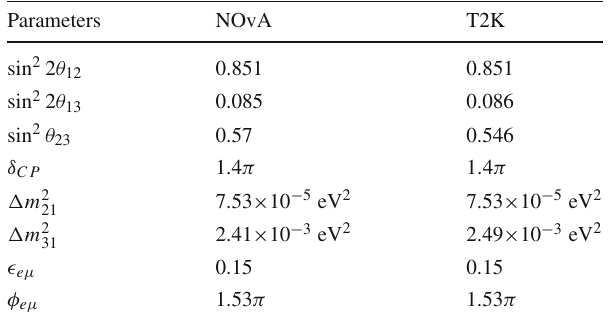
Table 1 True values of the oscillation parameters used in the analysis for NOvA [30] and T2K [32]